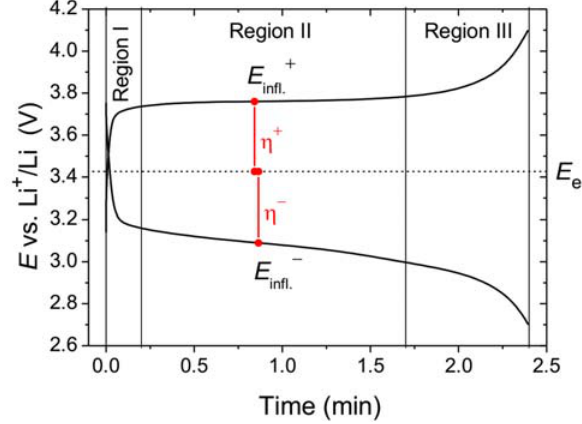
Figure 3. The inflection point criterion for determination of the va- lue of the total overpotential ( η ) demonstrated on a typical pair total of galvanostatic curves for LFP plotted as a function of time. The charge and discharge rates were the same (10C/10D). The char- and η – ) were obtained us- ge/discharge total overpotentials ( η + total total ing Eq. 3. Indicated are the three common regions of a LFP galva- nostatic